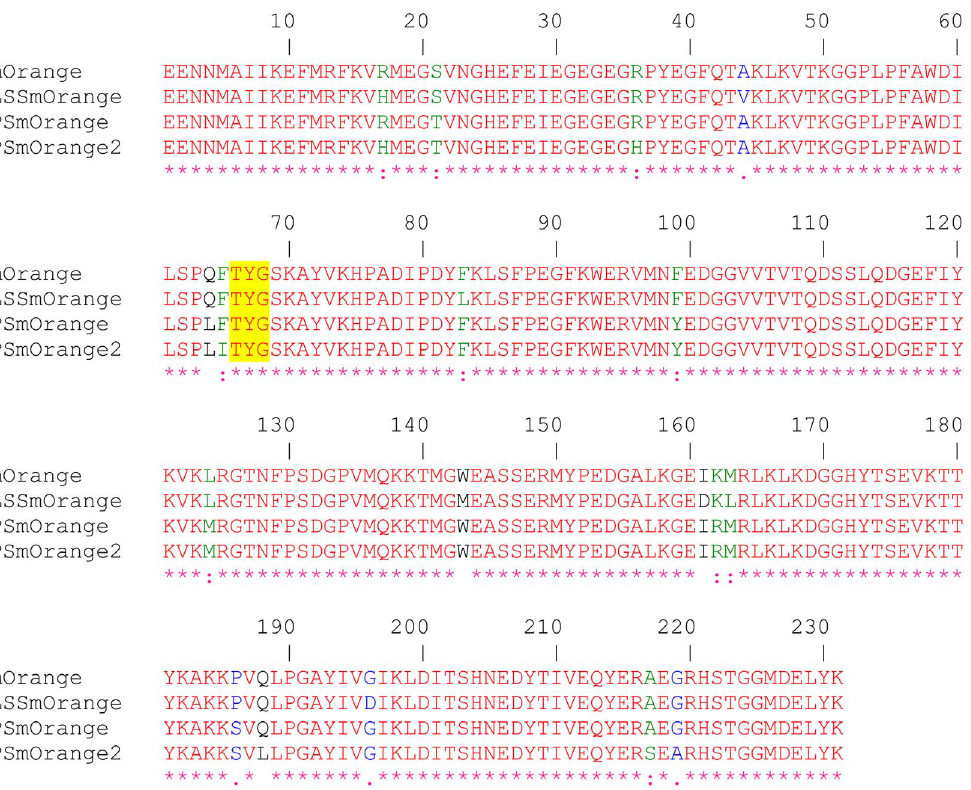
Figure 2. Amino acid alignment of mOrange, LSSmOrange, PSmOrange and PSmOrange2. The chromophore-forming tri-peptides are highlighted in yellow.